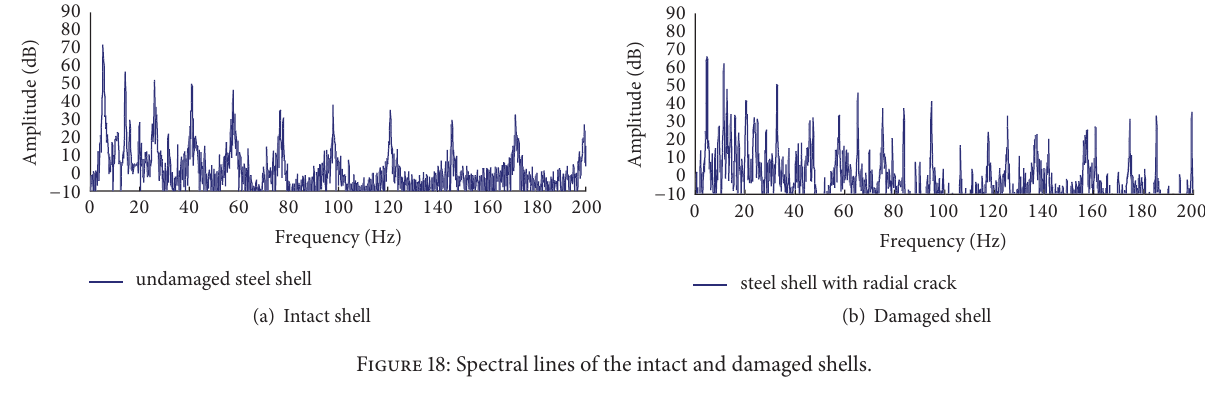
Figure 18: Spectral lines of the intact and damaged shells.